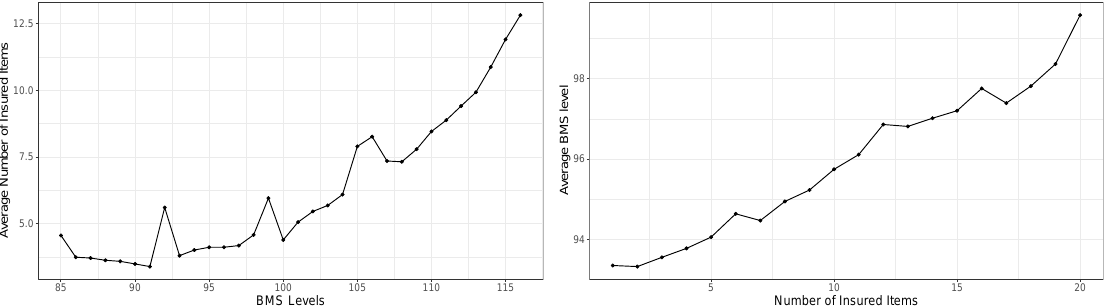
Figure 3. Average number of insured items by BMS level ( left ) and average BMS level by number of insured items ( right